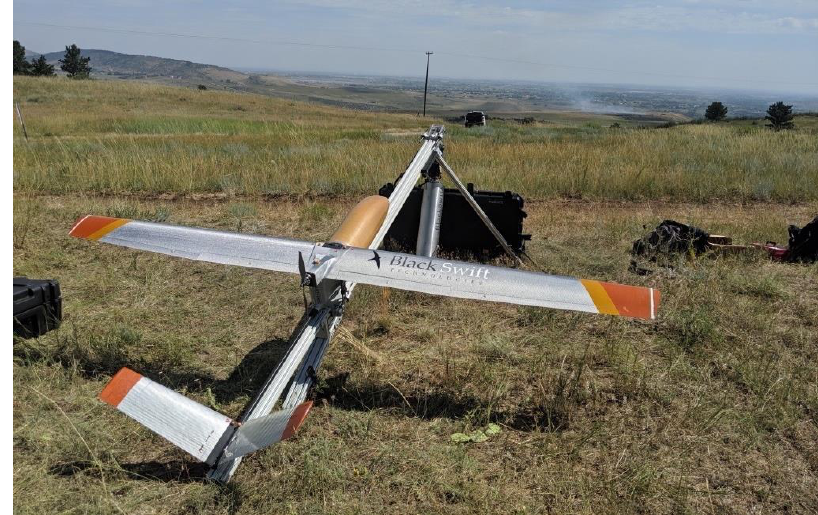
Figure 6. An S2 UAS carrying an AWSM payload ready for launch, Rabbit Mountain prescribed burn, Boulder County, Colorado, 31 July 2019. Boulder County, Colorado, 31 July 2019.